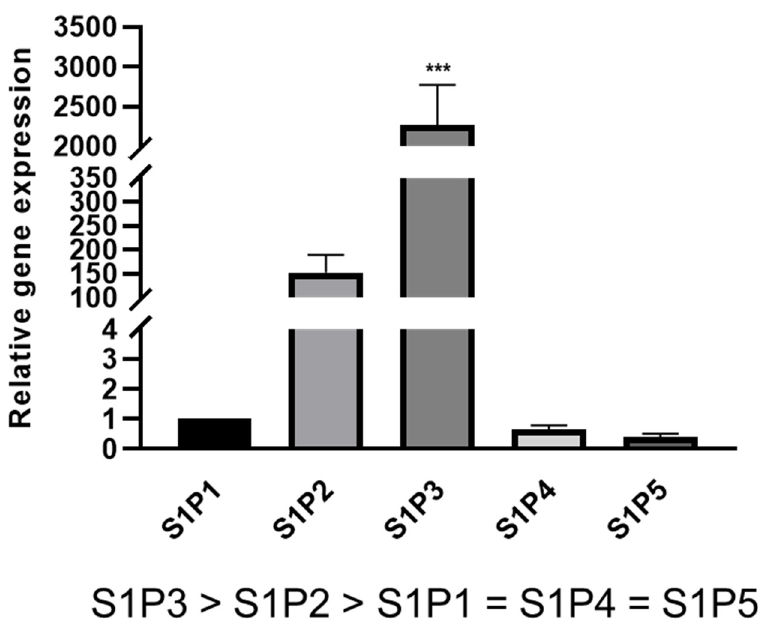
Figure 1. S1P receptor expression in cultured rat neonatal Schwann cells. Gene expression analysis revealed that S1P2 and S1P3 are highly expressed in SCs whereas S1P4 and S1P5 were slightly lower abundant compared to S1P1 . For statistical analysis, a one-way ANOVA with Dunnett’s multiple comparison test was used, *** p < 0.001 ( n = 5–6). Shown are the mean values ± SEM.